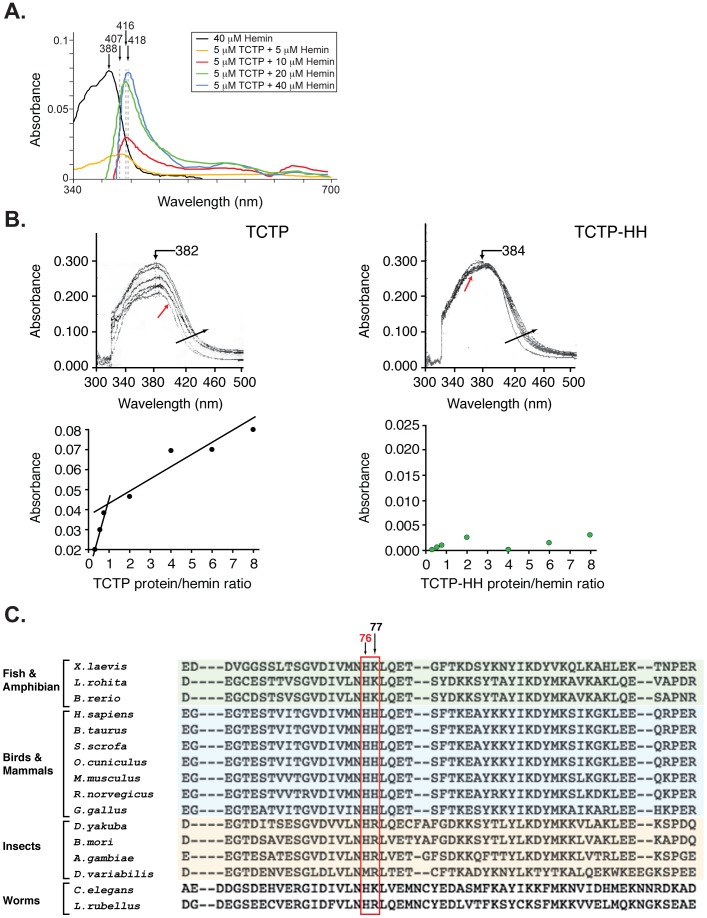
Heme binds TCTP in a conserved His residue.
A. Absorption spectra of recombinant TCTP (5 µM) in the presence of increasing concentrations of hemin (5 to 40 µM). For each hemin concentration, the spectra for the latter were subtracted from the hemin alone (black line). B. Absorption spectra of hemin after adding increasing concentration of either TCTP (top left panel) or TCTP-HH (His76Ala and His77Ala, top right panel) protein up to 8 mol equivalent of the hemin amount (black arrow). Free hemin spectrum is indicated with a red arrow. Bottom: Titration curves of hemin are represented as absorbance at 382 nm (for TCTP) and 384 nm (for TCTP-HH) as a function of the molar ratios of the protein to hemin. C. Sequence alignment of the surrounding His 76 and 77 residues in human TCTP and its homologs in other species. Multiple alignments were performed with the program CLUSTALW and refined manually. The arrows on top indicate the position of His76 (red arrow) and His77 (black arrow). Sequences shaded in green, blue, and orange correspond to species with the fish and amphibian, birds and mammals, and insects, respectively. No shaded sequences are species from worms. Accession numbers for all species are listed in the “Materials and Methods” section.